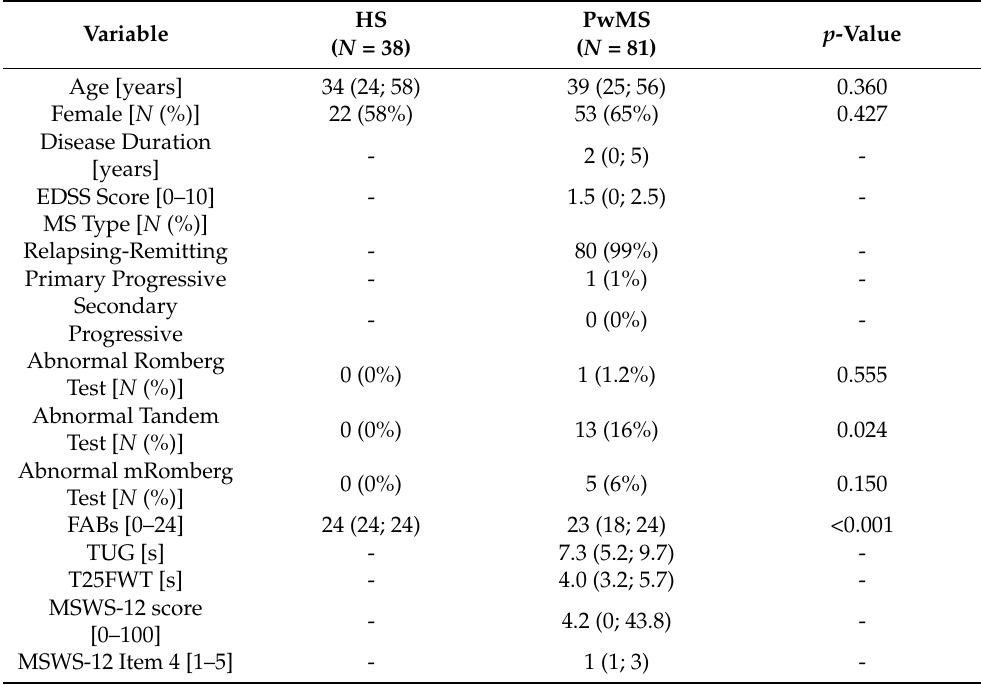
Table 2. Demographic and clinical characteristics of healthy subjects (HS) and people with multiple sclerosis